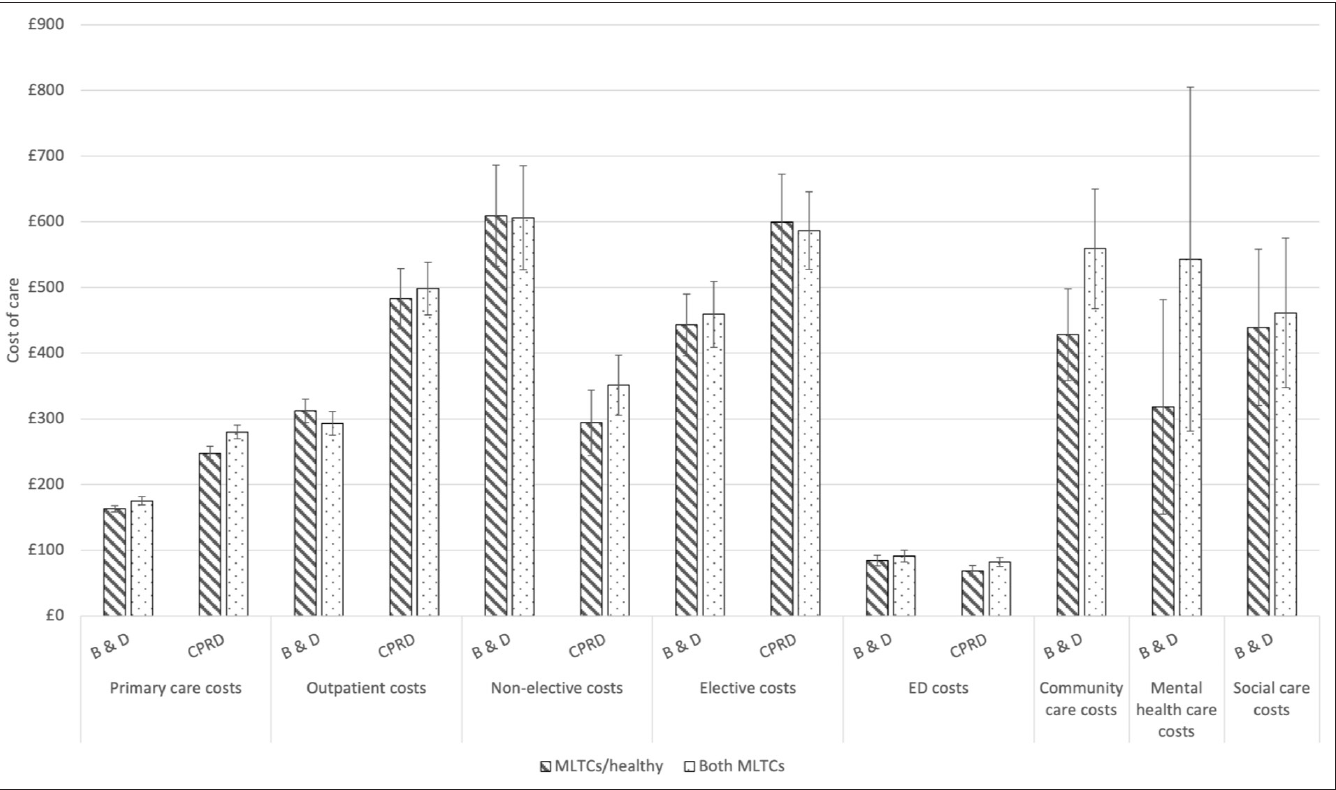
Figure 1 Cost of care by household multimorbidity status. B & D = Barking and Dagenham. CPRD = Clinical Practice Research Datalink. ED = emergency department. MLTCs = multiple long- term